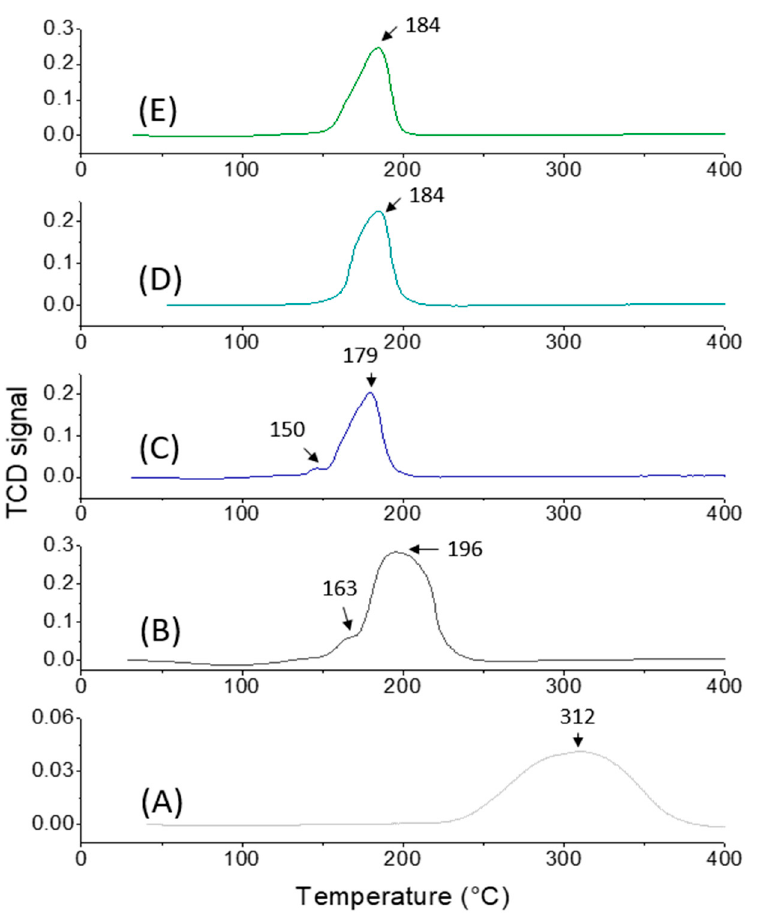
Figure 7. Temperature programmed reduction (TPR) patterns of RuO 2 @TiO 2 -sg ( A ), RuO 2 @TiO 2 -ns ( B ), RuO 2 @TiO 2 -SiO 2 3:1-ns ( C ), RuO 2 @TiO 2 -SiO 2 3:2-ns ( D ), and RuO 2 @TiO 2 -SiO 2 3:3-ns ( E ).